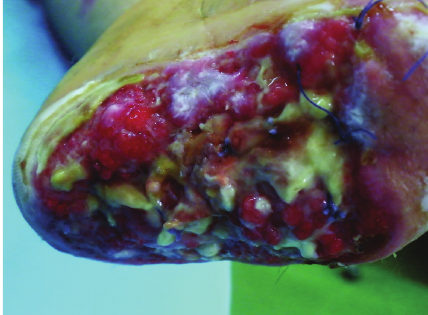
Figure 3: Ninth day after injury: complete graft loss and dark necrotic